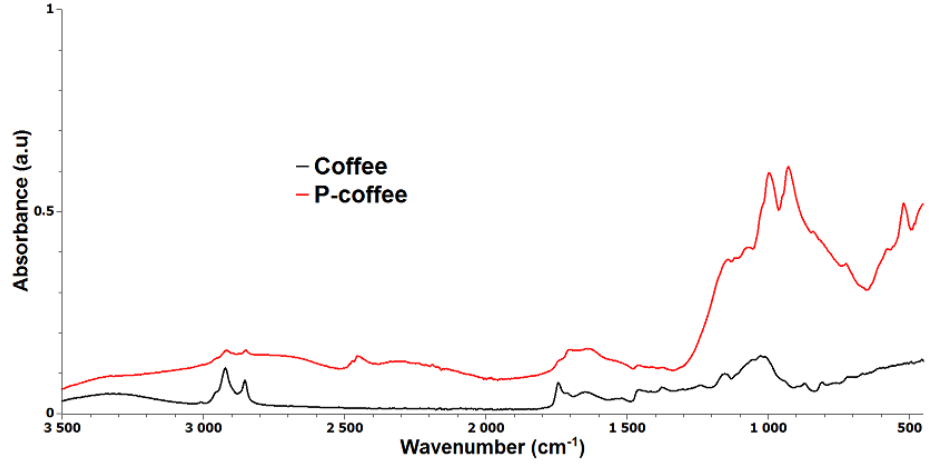
Figure 5. FTIR spectra of untreated (Coffee) and phosphorus treated coffee (P-coffee) samples.